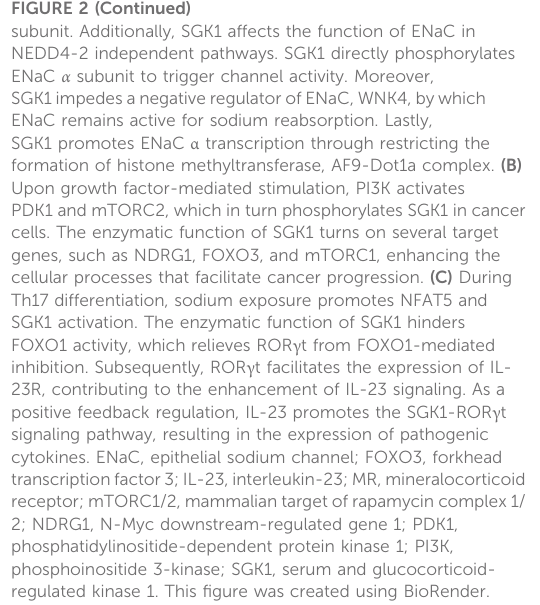
FIGURE 2 Overview: Role of SGK1 in biology. (A) Upon the aldosterone binding, cytosolic MR translocates into the nucleus and induces the transcription of SGK1 in renal epithelial cells. Concurrently, growth factors, such as insulin, activate PDK1, which then phosphorylates SGK1. Phosphorylated SGK1 inhibits NEDD4-2- mediated ubiquitination, which prevents the degradation of ENaC